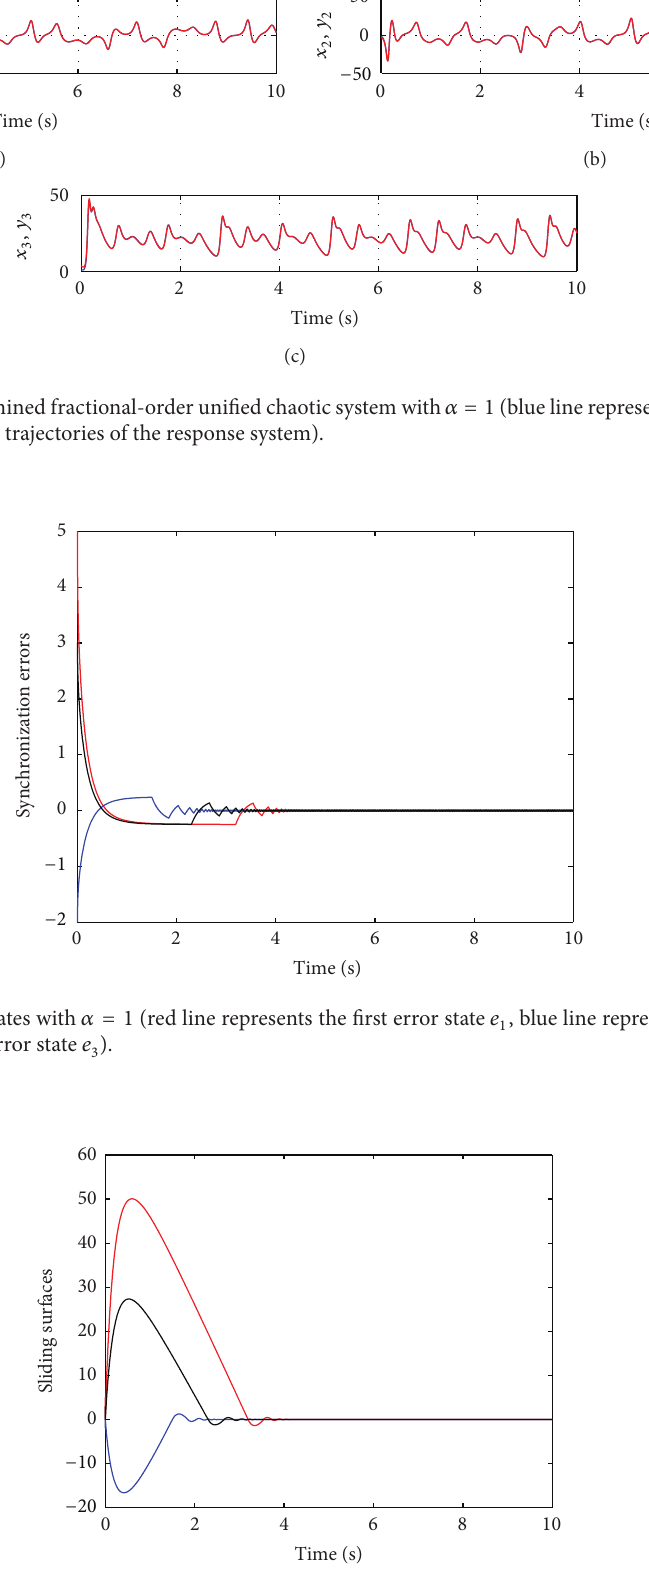
Figure 8: Sliding surfaces states with 𝛼 = 1 (red line represents the first sliding surface state 𝑠 1 , blue line represents the second sliding surface state 𝑠 2 , and black line represents the third sliding surface state 𝑠 3